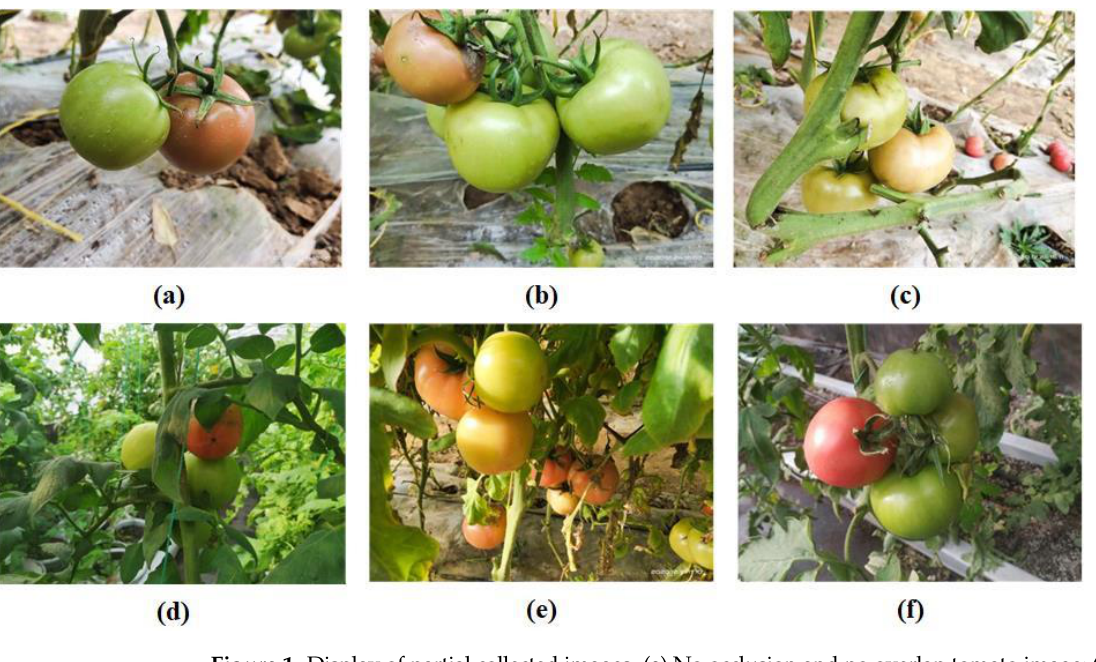
Figure 1. Display of partial collected images. ( a ) No occlusion and no overlap tomato image; ( b ) heavily overlapped tomato images; ( c ) branches occlusion tomato images; ( d ) leaves occlusion tomato images; ( e ) branches and leaves mixed occlusion tomato images; ( f ) slightly overlapped tomato images.